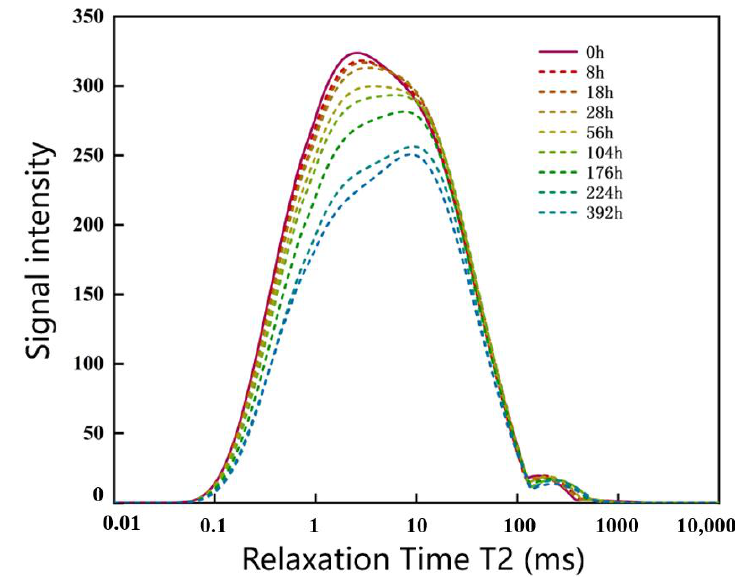
Figure 4. Development of T 2 of sample YSS at 1 atm.